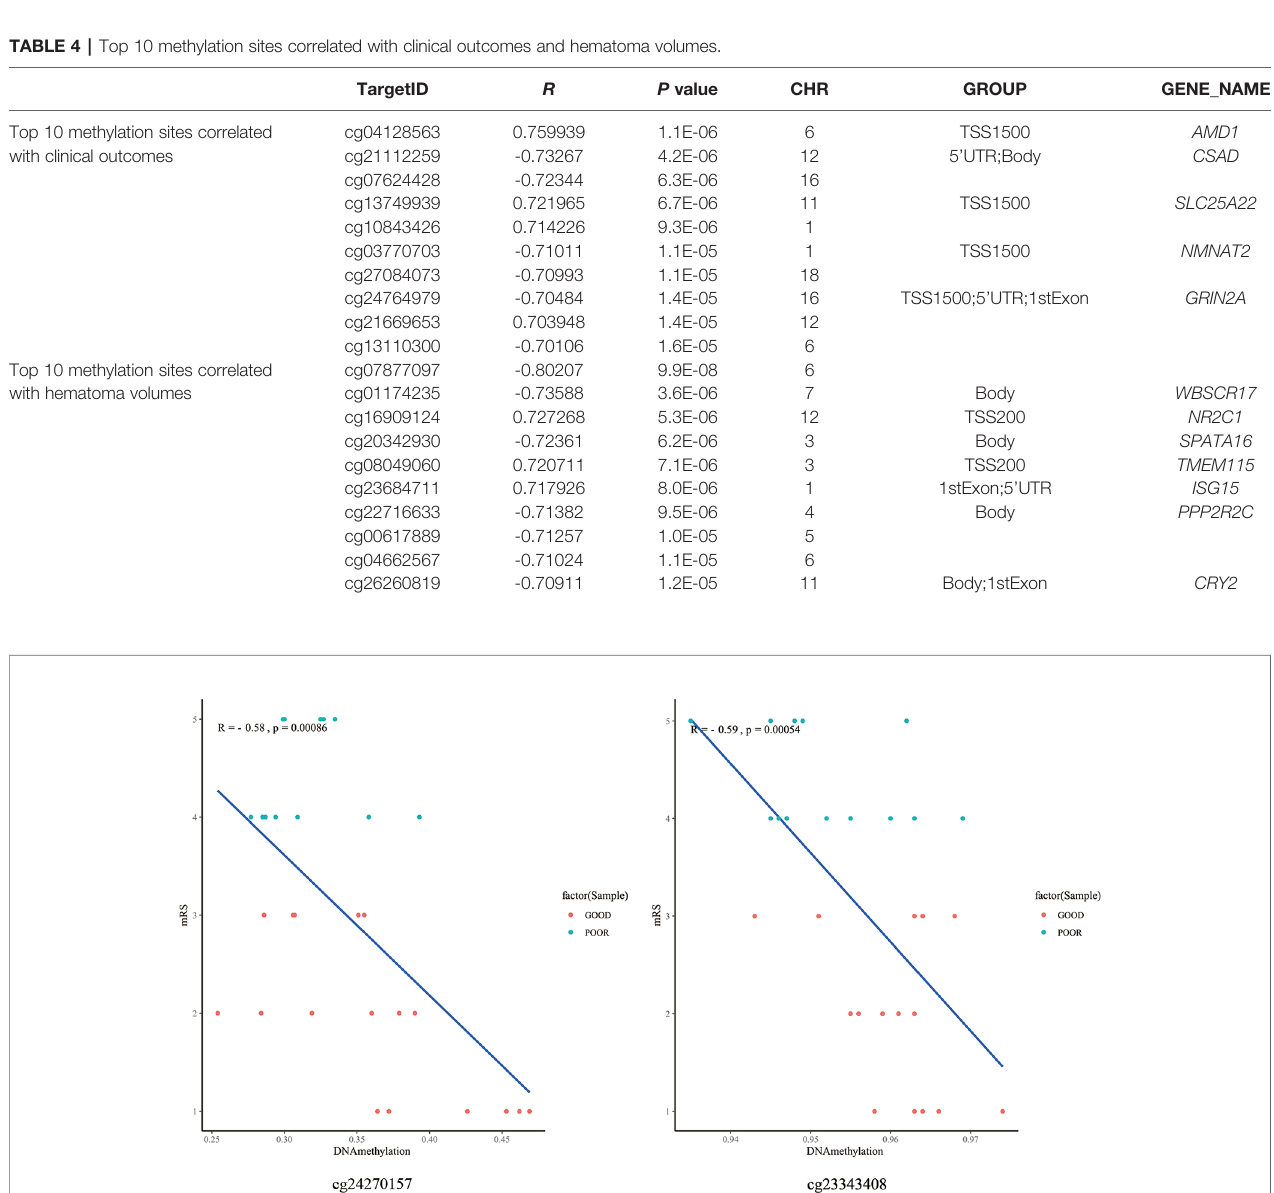
FIGURE 8 | The DNA methylation sites involved in immunological homeostasis and mRS correlation scatter plot. degrees of methylation in cg24270157, cg23343408 are negatively correlated with the 3 months mRS score (R=-0.58, R=-0.59), red dots indicate the favorable outcome patients and the blue means poor